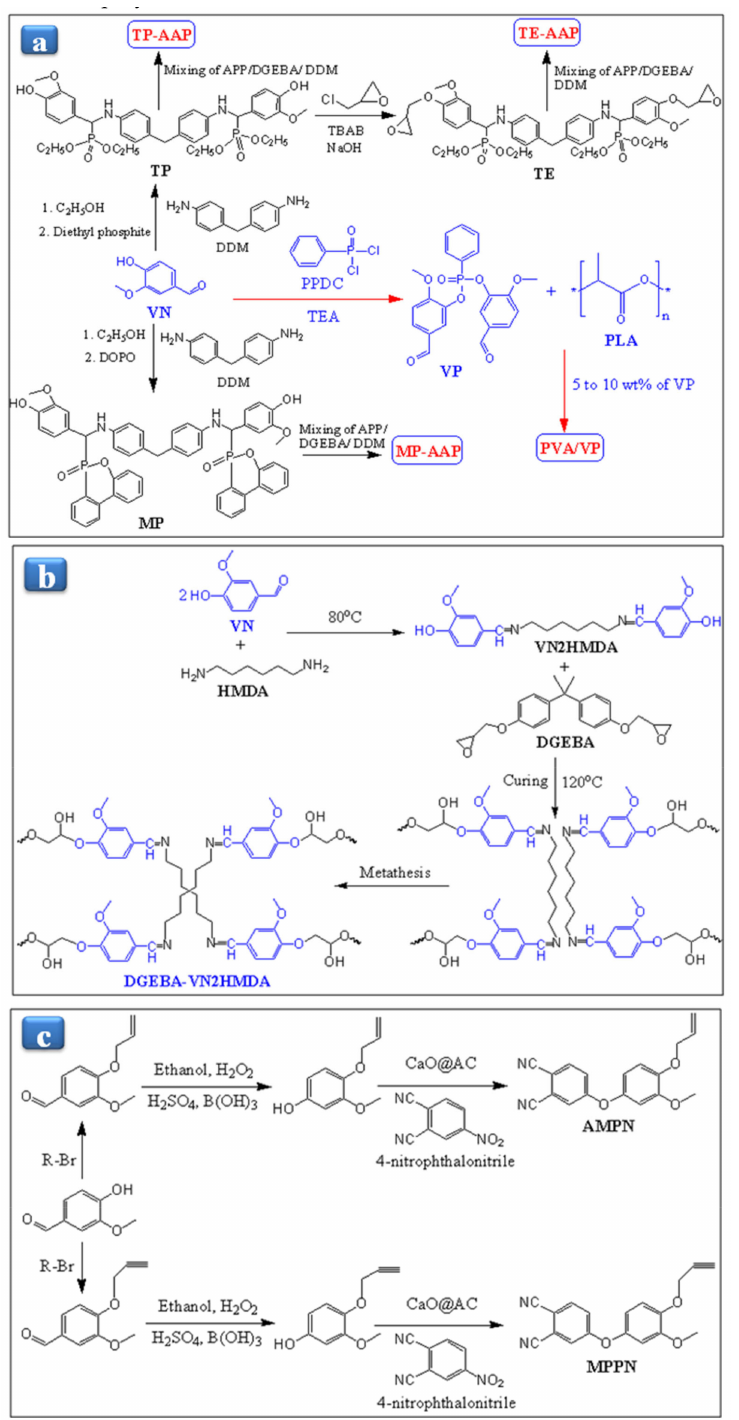
Figure 9. An illustration reaction scheme for the synthesis of ( a ) TP-AAP, MP-APP, TE-APP-based materials, and PVA/VP composite, ( b ) VN2HMDA, and curing reaction mechanism of DGEBA and VN2HMDA, and ( c ) AMPN and